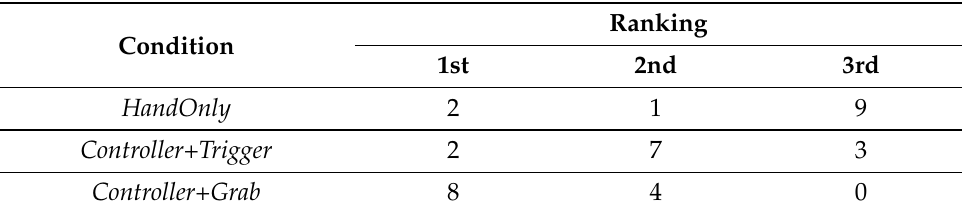
Table 4. The number of mentions when asking the participants to rank the interaction methods as the most liked, the second and the least